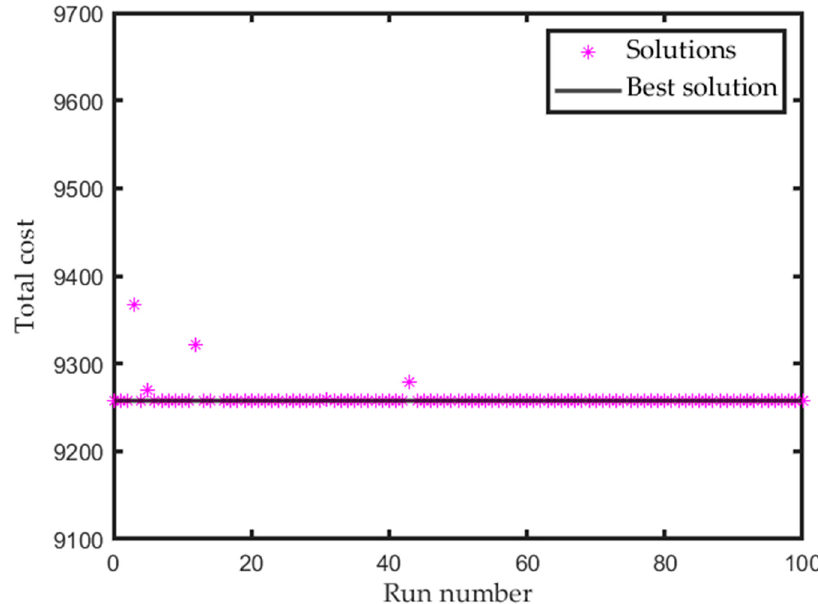
Figure 11. Solution changes for IUVMFO running.